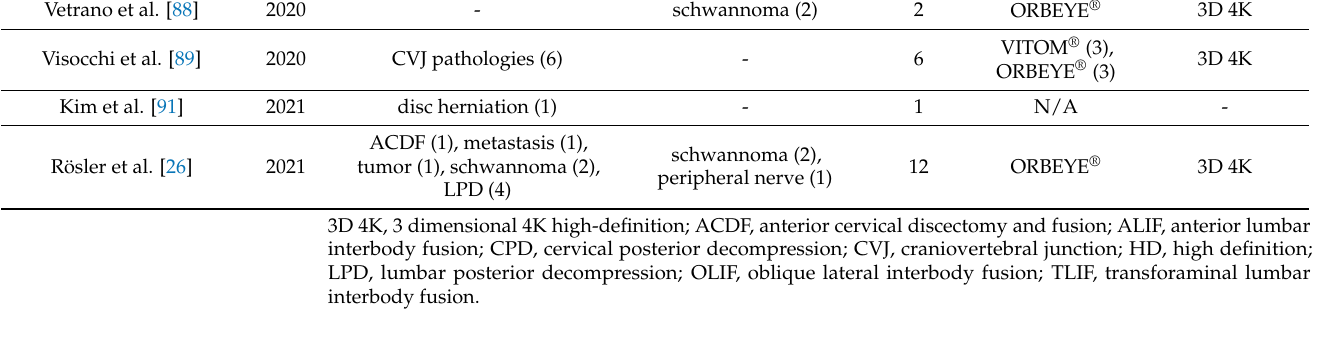
Table 4. Summary of laboratory studies included in the